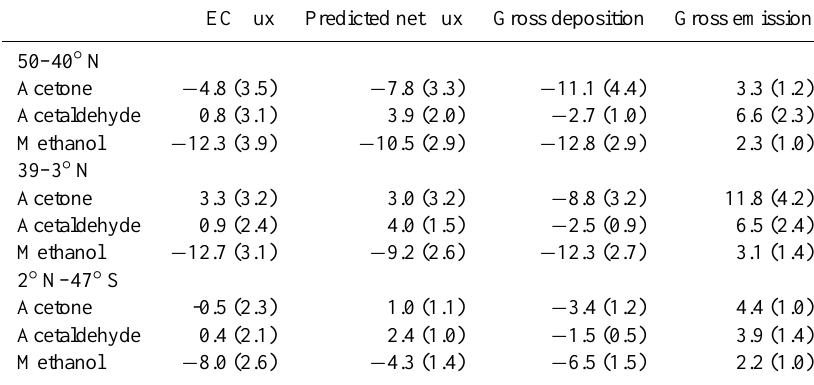
Table 1. Summary of fluxes (µmolesm − 2 d − 1 ) and associated uncertainties in parenthesis.